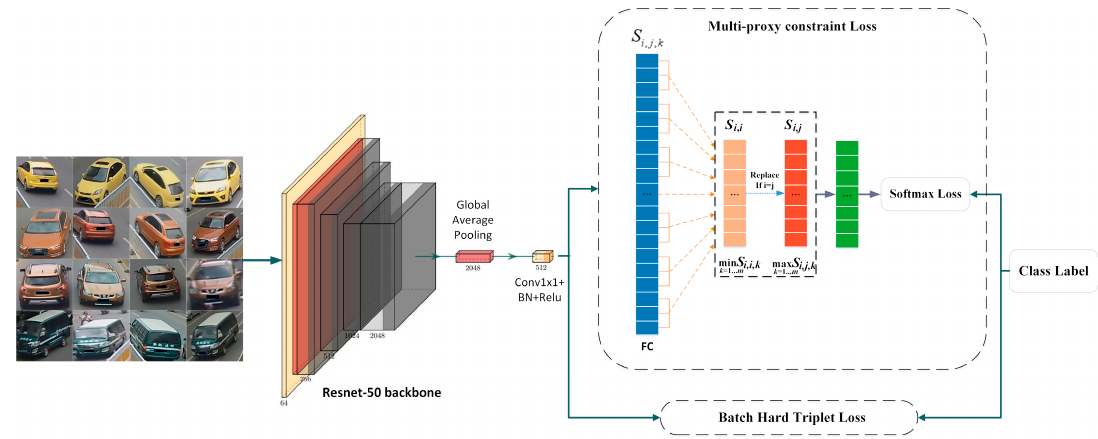
Figure 3. The proposed network architecture. We add a block consisting of Conv1x1, BatchNorm, and Rectified Linear Unit (ReLU) to reduce the dimension of the features from 2048 to 512. The multi-proxy constraint loss function and the batch hard triplet loss function are jointed to learn the feature embedding space.